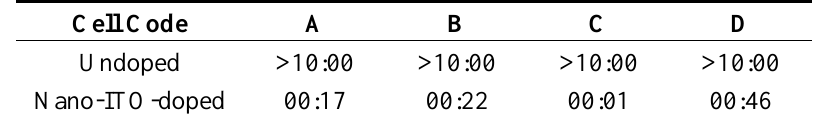
Table 1. The statistics of the sticking durations for the images of four pairs of undoped and nano-ITO-doped cells after an electrostatic discharge (ESD) of 8 kV stimulus. The time ratio is expressed in the format of minute:second. The concentration of ITO in the doped samples was 0.2 wt %. The resistivity of the LC is 1 × 10 13 Ω∙cm.